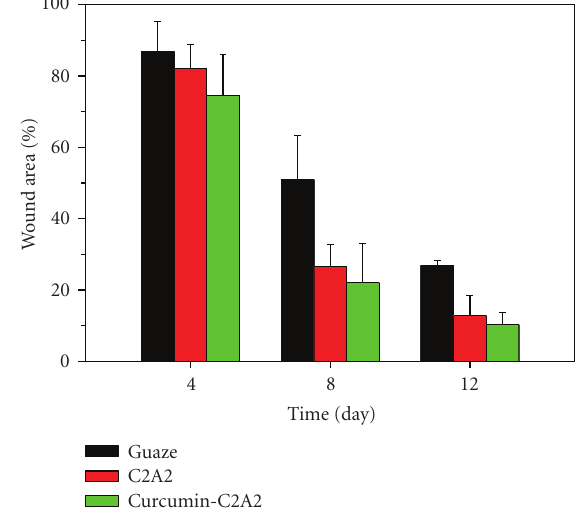
Figure 7: Total wound area of skin over time as a percentage of original wound